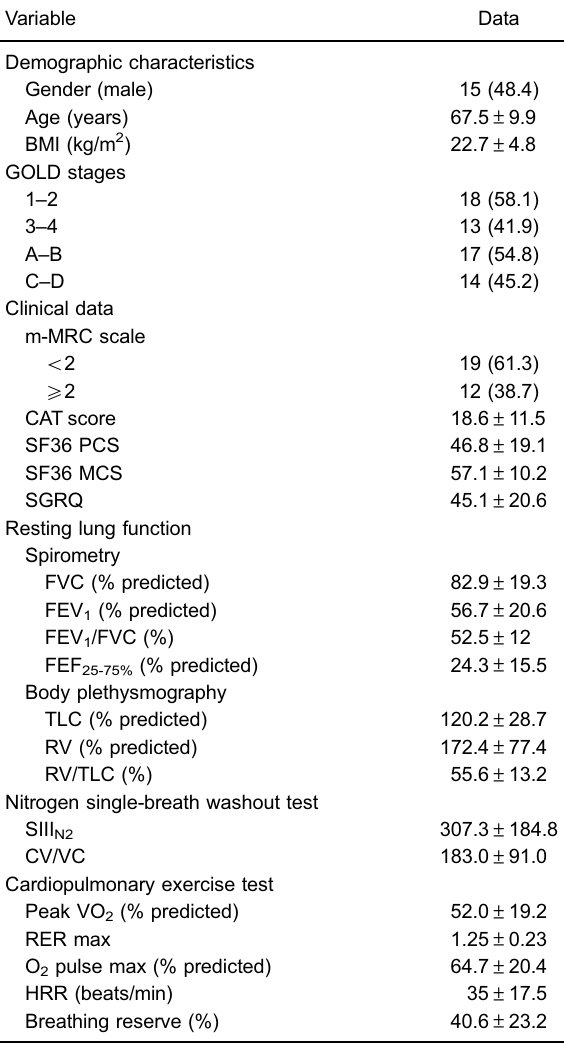
Table 1. Demographic and clinical data, resting lung function parameters, and cardiopulmonary exercise test data of the patients